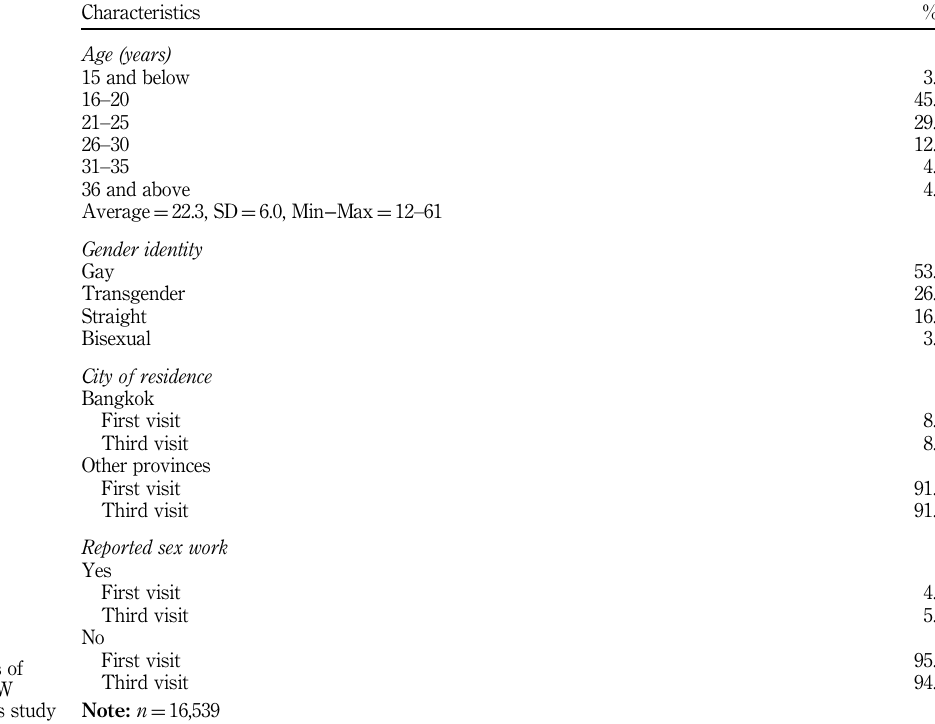
Table II. Characteristics of MSM and TGW samples in this